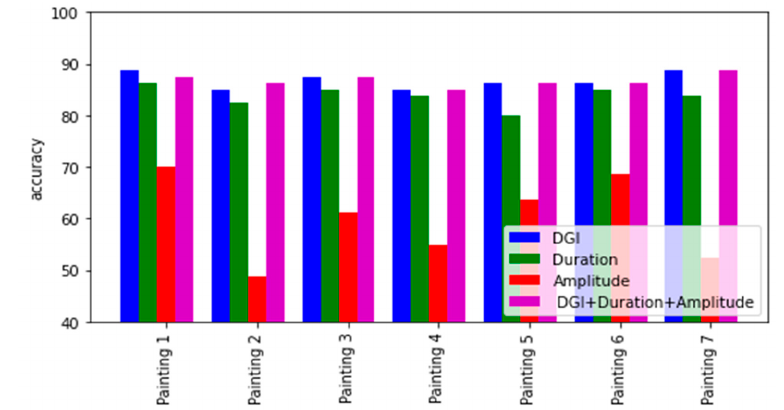
Figure A20. Logistic regression scores for the seven DGI based datasets. Table A6. support vector machine scores for the seven DGI based data sets.